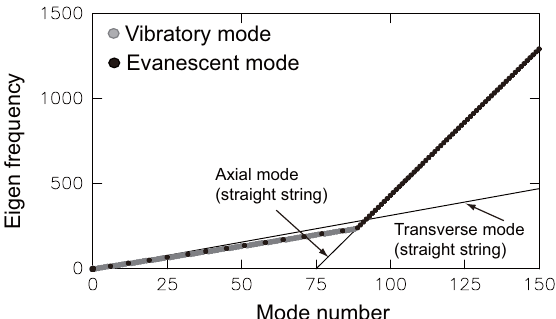
Figure 5. Plots of the eigenfrequencies (imaginary part of the eigenvalue) against the mode numbers. The lines represent the eigenfrequencies of the axial and transverse vibrations of a straight